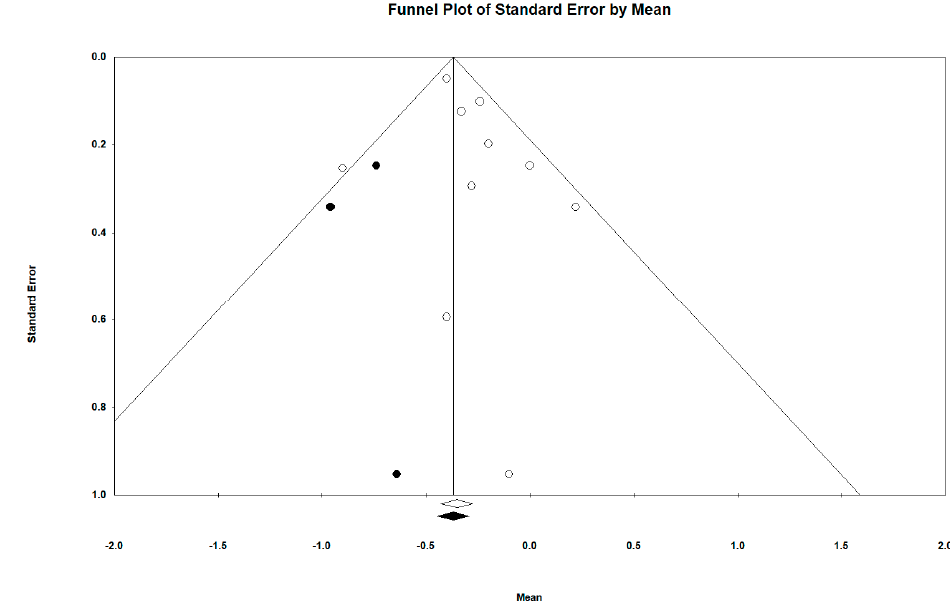
Figure 17. Funnel diagram or “funnel plot” of the standard error (axis of the Y) by the DEM (axis of the X), after incorporating the Duval and Tweedie “trim and fill” procedure. Pre-post difference of BMI (Kgr/m 2 ) between groups and all